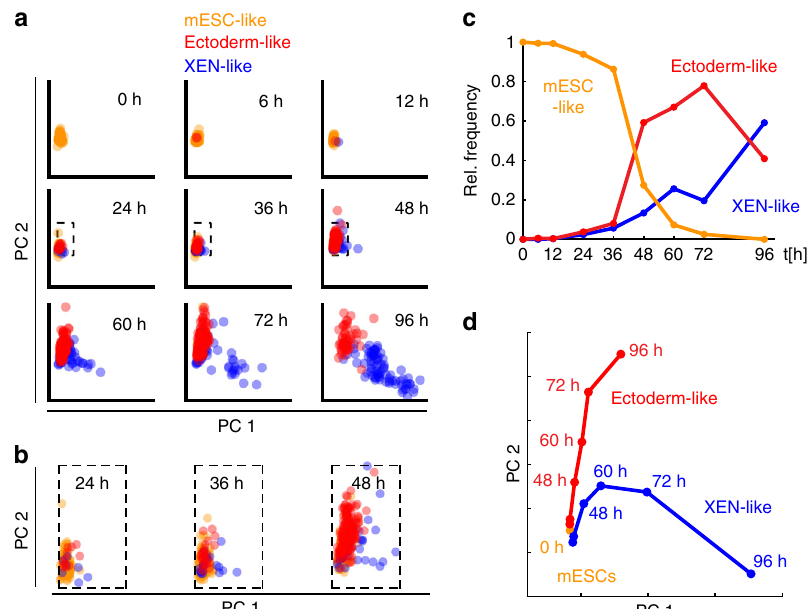
Fig. 2 mESCs showed gradual adoption and divergence of lineage speci fi c expression pro fi les. a Principal component analysis of single-cell expression pro fi les. Principal components were calculated across all cells and time points. Cells measured at the indicated periods of RA exposure were placed in the space of the fi rst two principal components. Each data point corresponds to a single cell. Cells were classi fi ed as mESC-like (orange), ectoderm-like (red) and XEN-like (blue). Classi fi cation was based on Pearson correlation between expression pro fi les of individual cells and mean expression pro fi les of mESCs at 0 h or ectoderm-like and XEN-like cells after 96 h of RA exposure. An individual cell is identi fi ed with the cell type with which it is most strongly correlated. b Same data as in a for three select time points (24 h, 36 h and 48 h), zoomed in on the areas indicated by dashed rectangles in a . c Relative frequencies of cells classi fi ed as mESC-like, ectoderm- or XEN-like in the same way as in a . d Average movement of ectoderm- and XEN-like cells in the principal component space during RA differentiation. The positions of cells of the same type were averaged at the indicated time